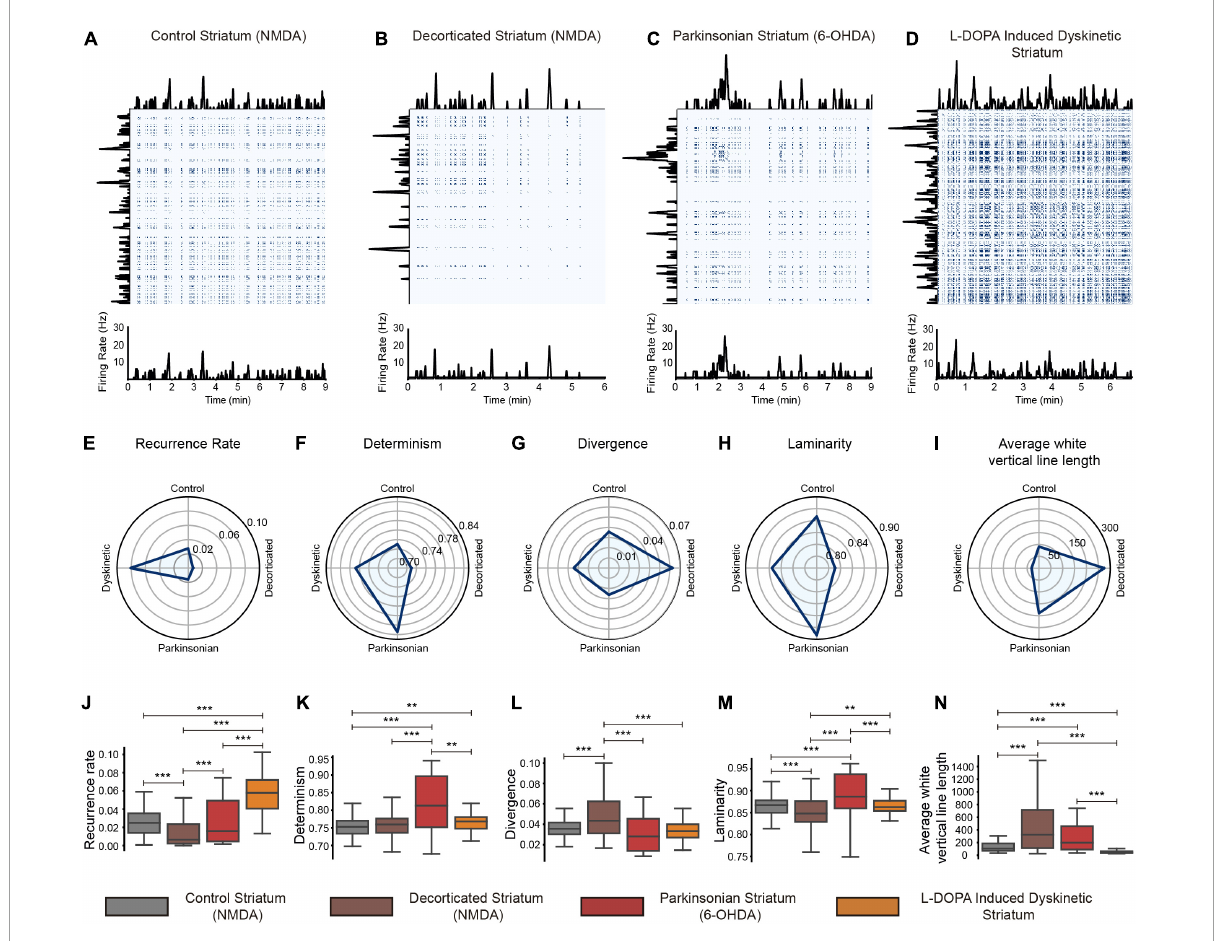
FIGURE6 Recurrence quantification analysis of the firing rate of representative neuronal ensembles. (A–D) Top: recurrence plots of the firing rate of neuronal ensembles of the striatum in the different conditions. At the left and upper ends of the matrices, the traces being analyzed are observed, and for better appreciation, they are also shown at the bottom. Note that, except for matrix B, all conditions exhibit lattice structures, differing in their spacing. (E) The recurrence is higher for the dyskinetic state. (F) The determinism is higher for the parkinsonian condition, suggesting predictability. (G) The divergence is higher for the decorticated condition, suggesting a more chaotic state. (H) The laminarity score is for the parkinsonian circuits, the most regular. (I) The average white vertical line length is higher for the decorticated state, where recurrent times are the longest–almost isolated ensembles. The last row (J–N) shows the comparisons between the samples determined in the complete dataset and essentially confirms what was observed in the representative example quantifications shown in the upper row (E–I) . The actual values can be read in the main